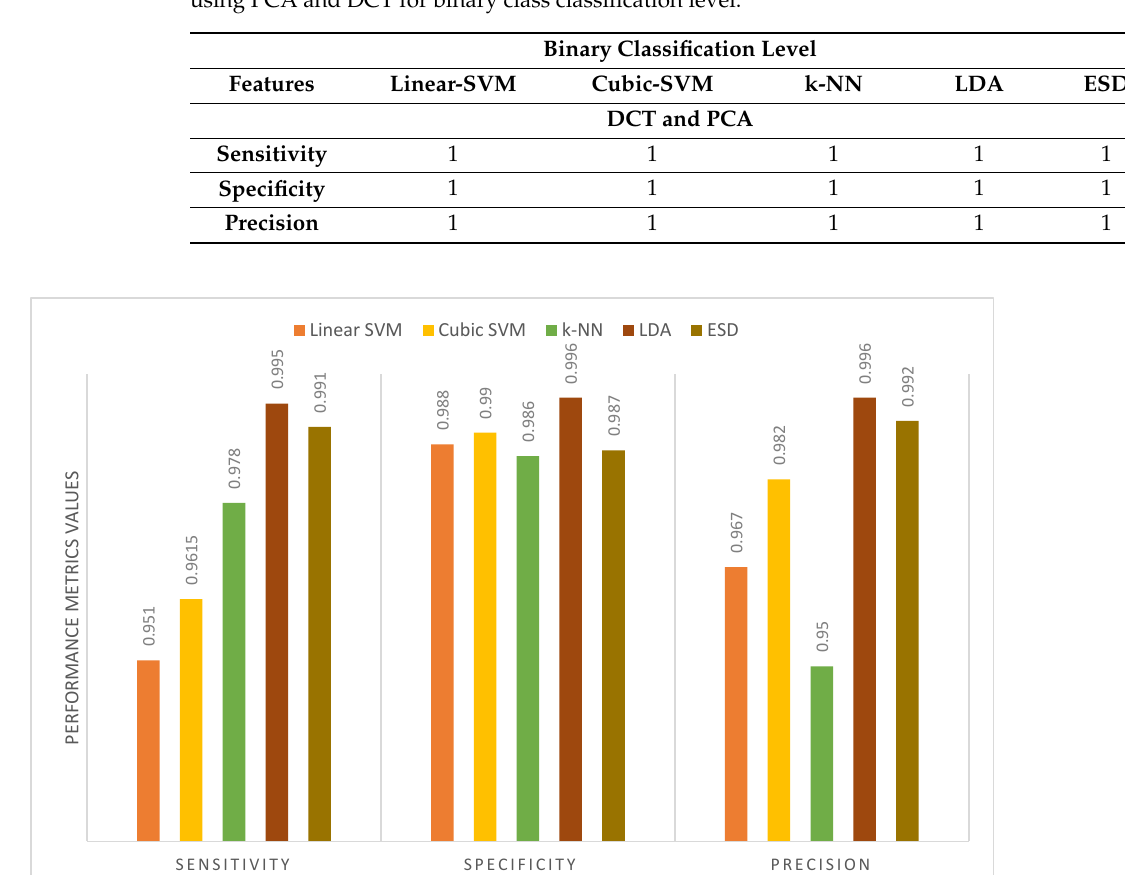
Figure 9. The performance metrics for the five classifiers used in MB-AI-His CADx after the fusion using PCA for the multi-class classification level.